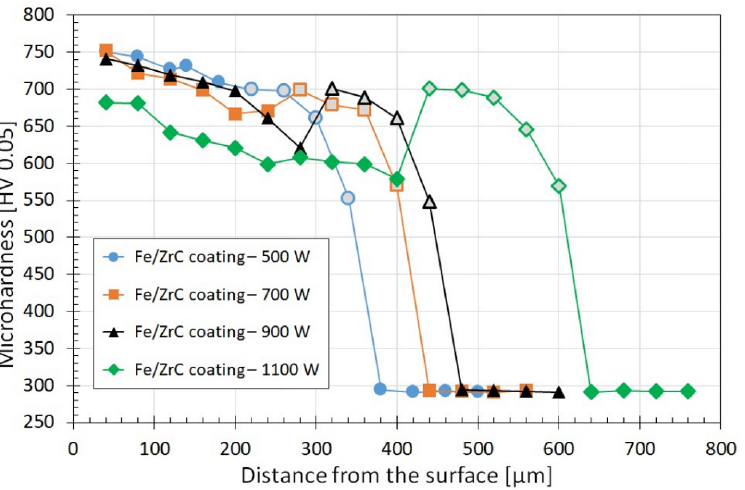
Figure 16. Microhardness of Fe/ZrC coating produced on steel using different laser beam power- markers with a gray background on the graph indicating that the measurements are in the heat- affected zone.